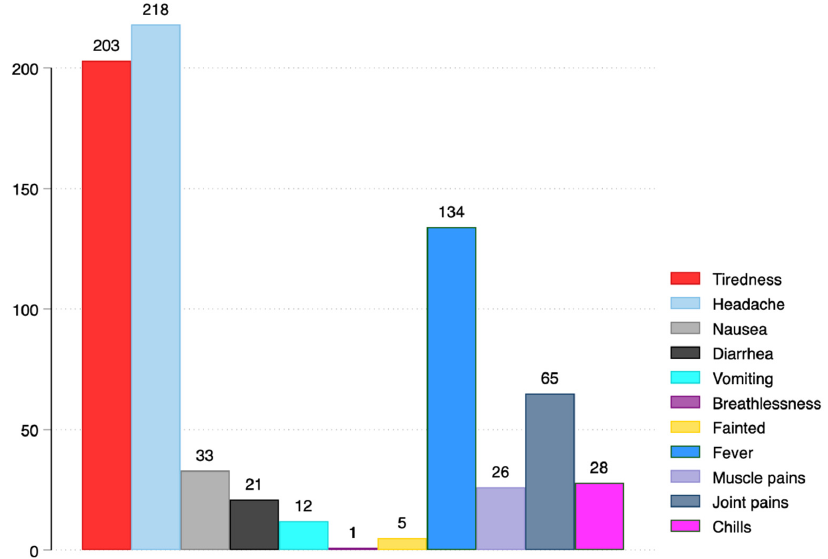
Figure 1. Local side-effects following vaccination with Oxford/AstraZeneca.